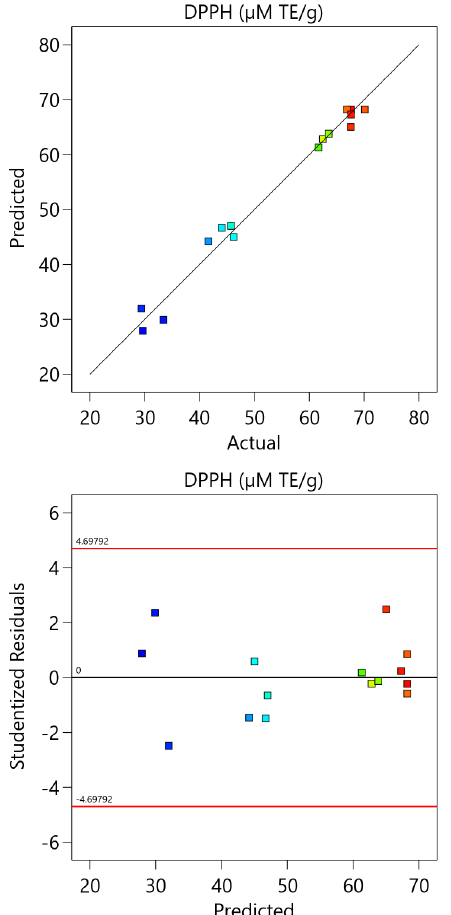
Figure A2. The comparison between the experimental and the predicted data and the residual analysis for the optimization of DPPH assay.